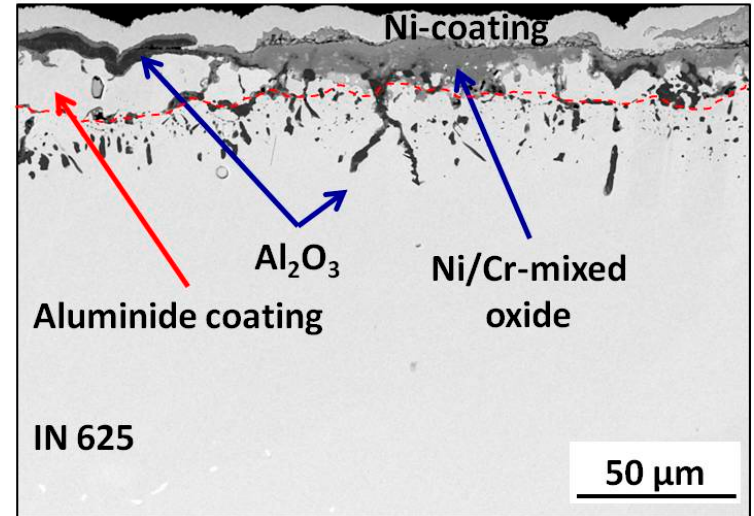
Figure 14. SEM/BSE image showing cross-section of an aluminide coating formed on grit-blasted IN 625 after a thermal shocking test with after 200 cycles, showing the area with completely spalled-off aluminide coating.